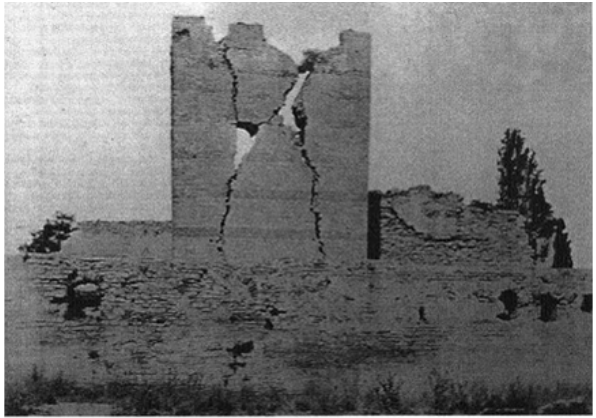
Fig. 3. The iso intensity curves of the 1894 earthquake in the Mar- mara Region (Eginitis, 1895).